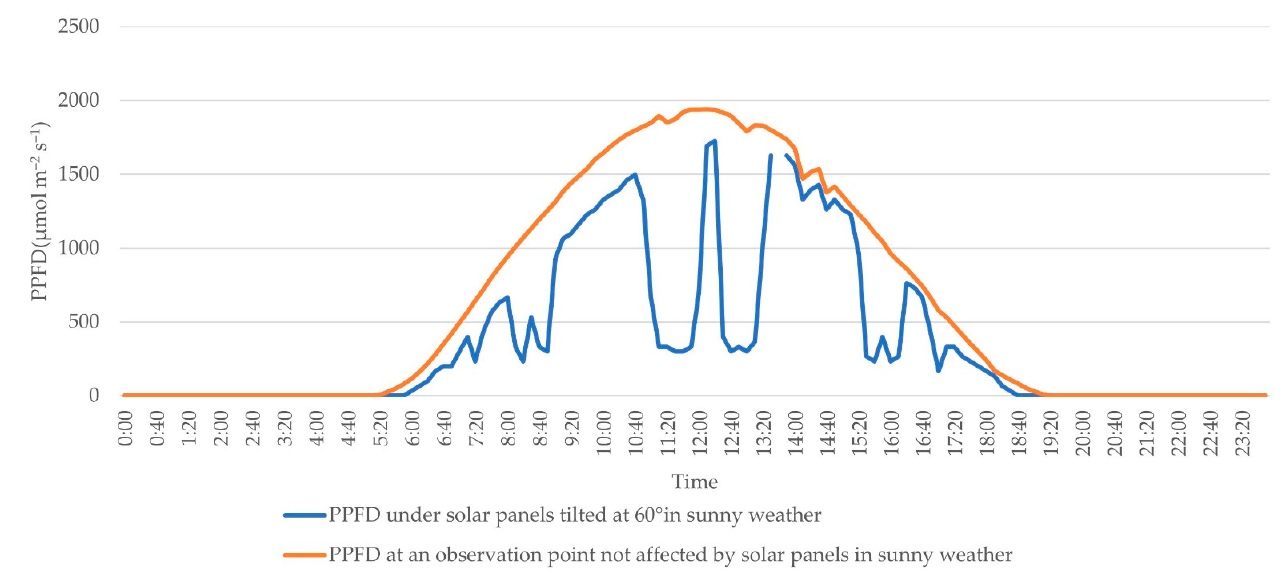
Figure 1. Difference in PPFD above and below solar panels. From Yajima et al. [50].